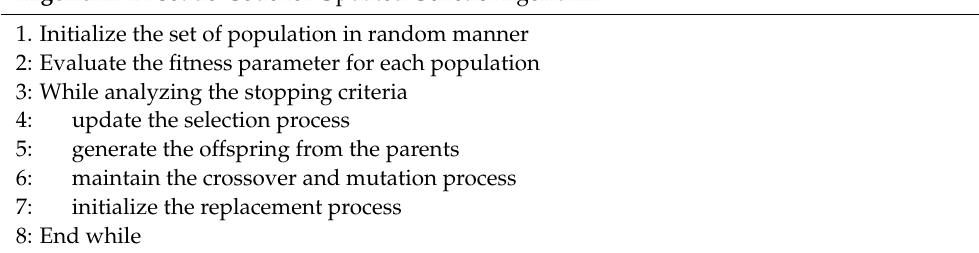
Algorithm 2 Pseudo-Code for Updated Genetic